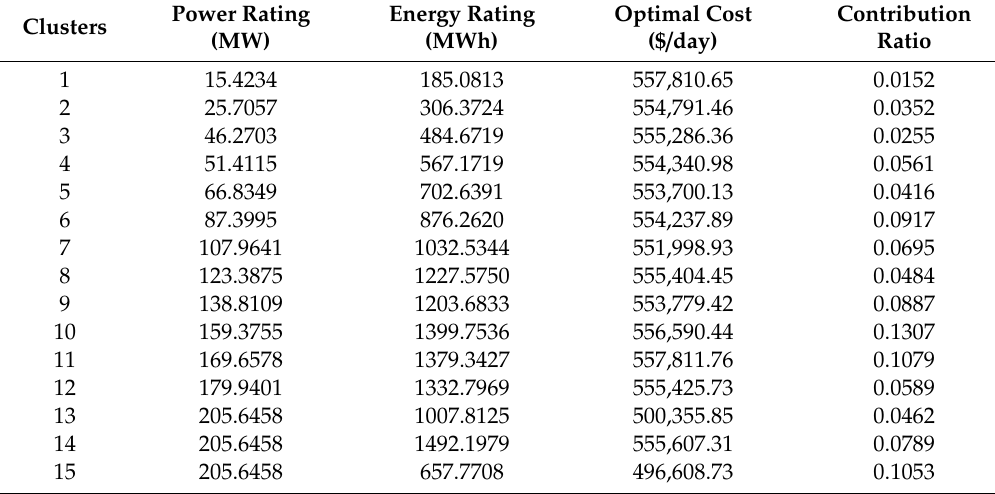
Table 3. Computation results of representative data for case